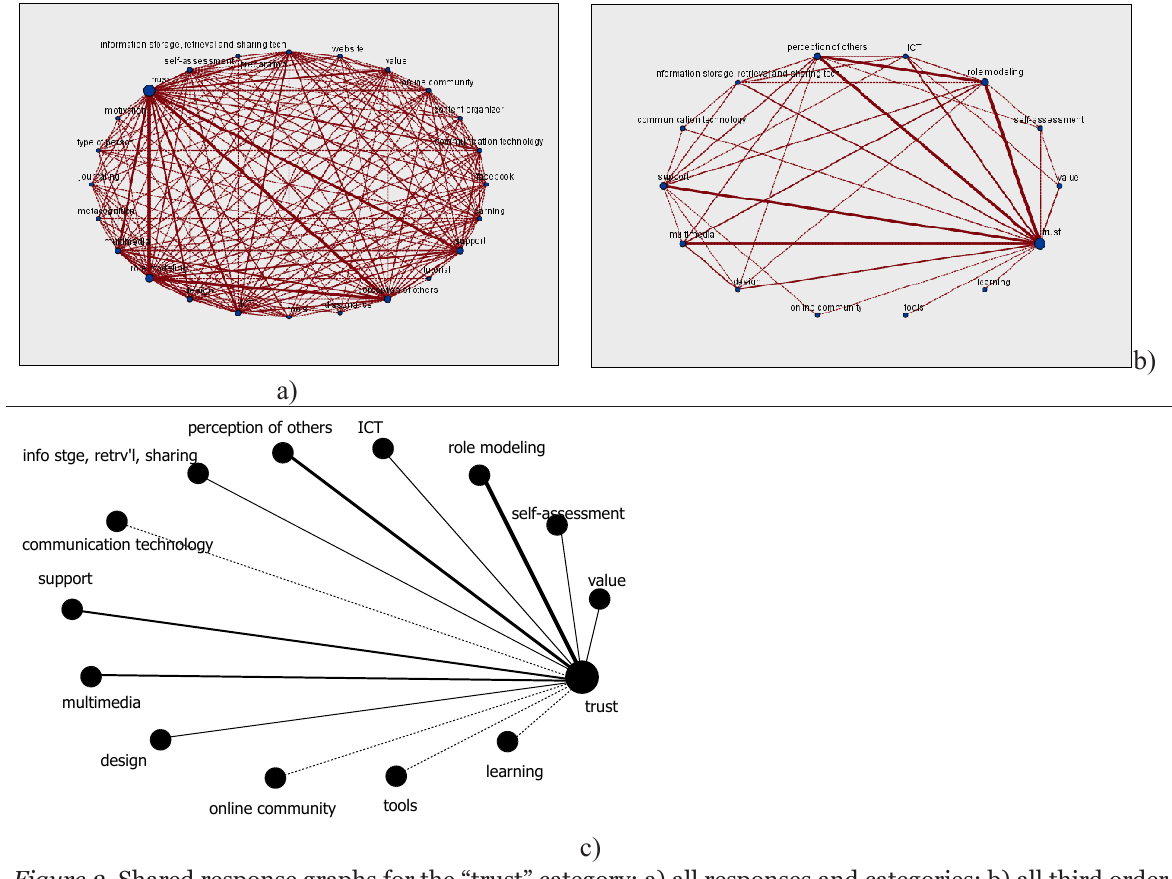
Figure 3. Shared response graphs for the “trust” category: a) all responses and categories; b) all third order categories removed; c) all remaining second degree categories removed, leaving a first order category